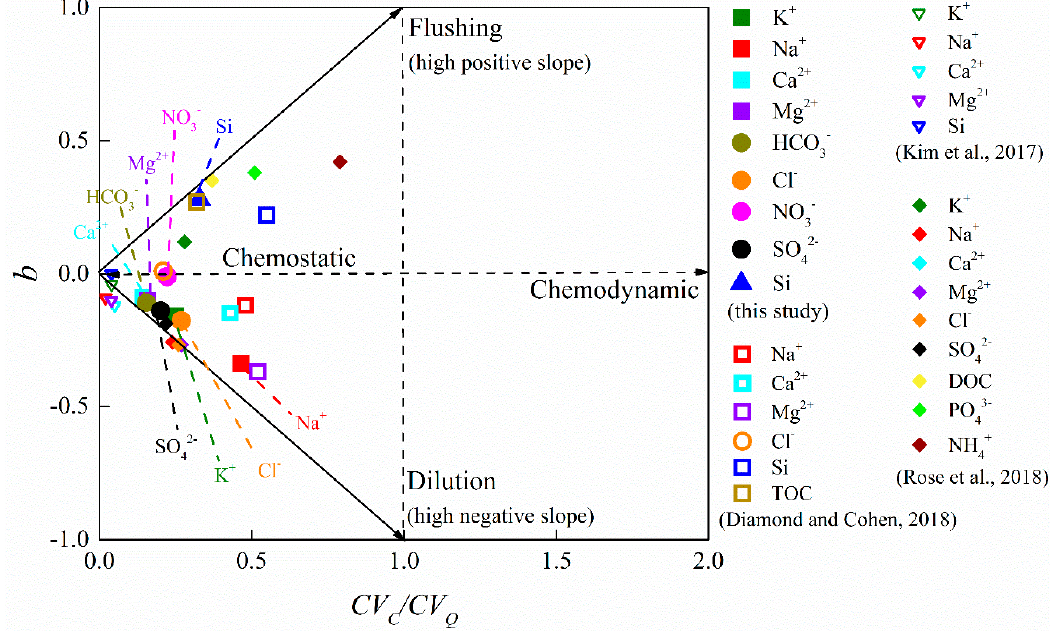
Figure 3. Plot of slope ( b ) versus CV C /CV Q for riverine dissolved solutes in the Liujiang River.